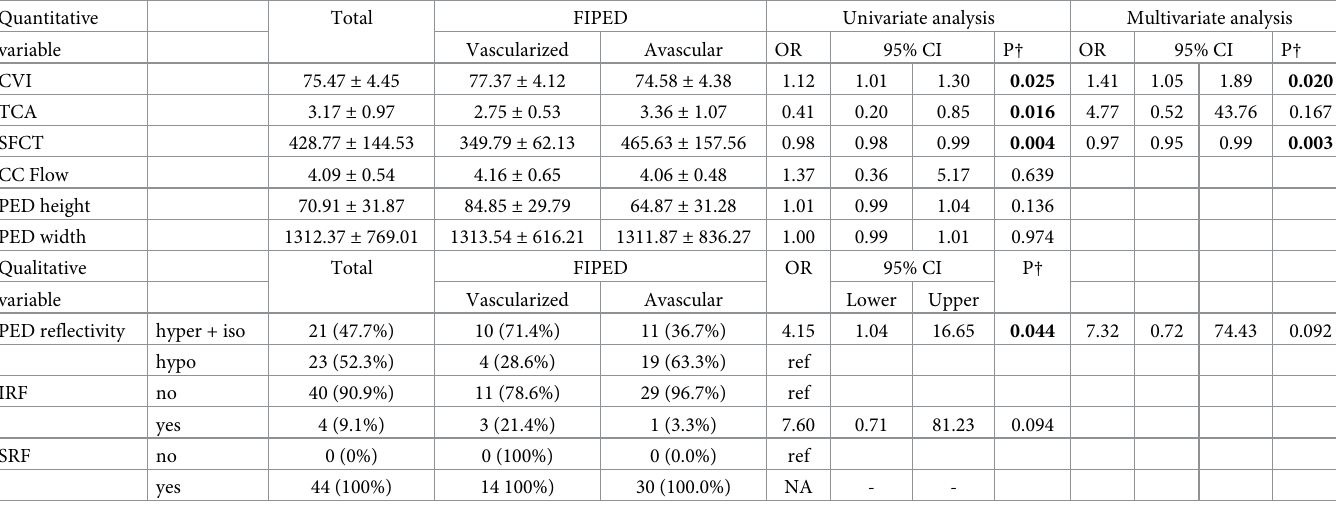
FIPED: Flat irregular pigment epithelial detachment, CVI: Choroidal vascular index, SI: Stromal index, TCA: Total choroidal area, SFCT: Subfoveal choroidal thickness, CC flow: Choriocapilaries flow, IRF: Intra retinal fluid, SRF: Subretinal fluid, AUC: Area under the